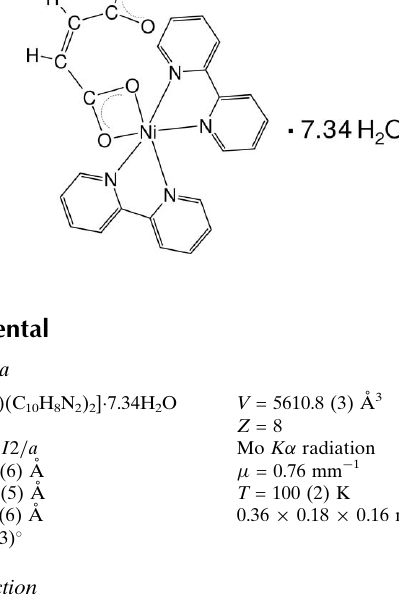
Stoe IPDS diffractometer Absorption correction: multi-scan (Blessing, 1995) T min = 0.772, T max = 0.888